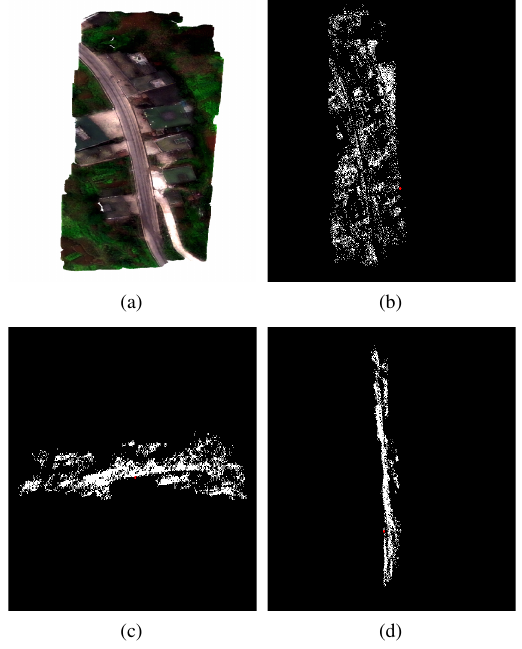
Figure 3. (a) RGB display of the study area. (b), (c) and (d) are captured from different angles of the 3D point